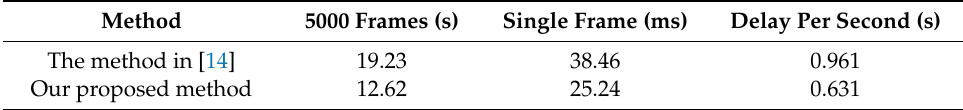
Table 2. Time comparison of different methods on image processing.